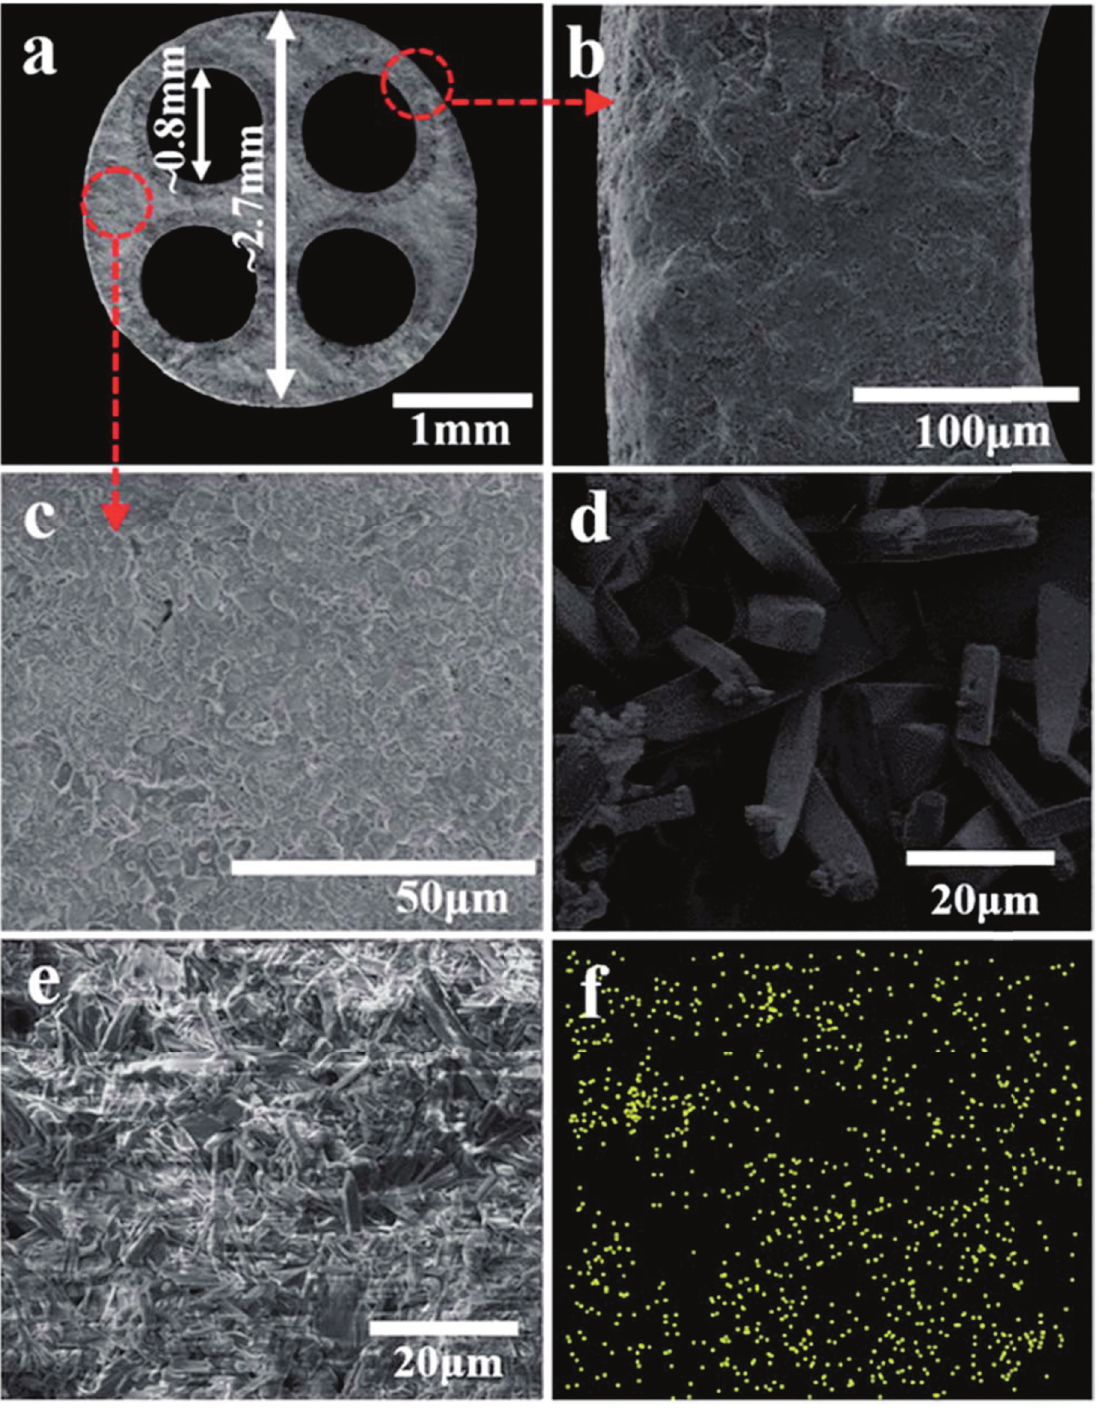
Figure 6: SEM images of SrFe 0.8 Nb 0.2 O 3- δ multihollow fibres with supported molten salt. (a) Cross-sectional view; (b) outer layer; (c) high- resolution cross-sectional view; (d) inner layer; (e) outer surface; (f) EDX of potassium in cross-sectional view